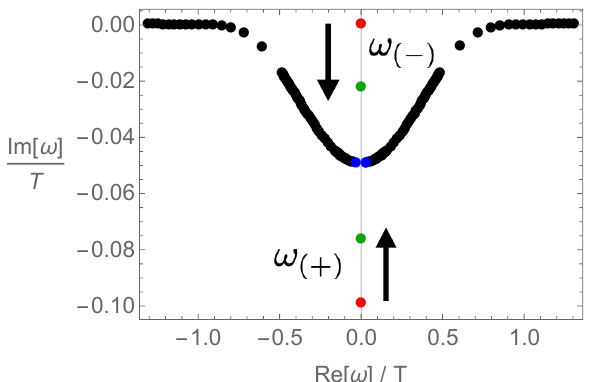
Figure 5 . The dynamics of the lowest collective modes in the transverse sector at k = 0 by decreasing the reduced temperature from T/T = 1 to 0 . 3 (in the direction of the arrows). The (red, c green, blue) data are the same as in figure